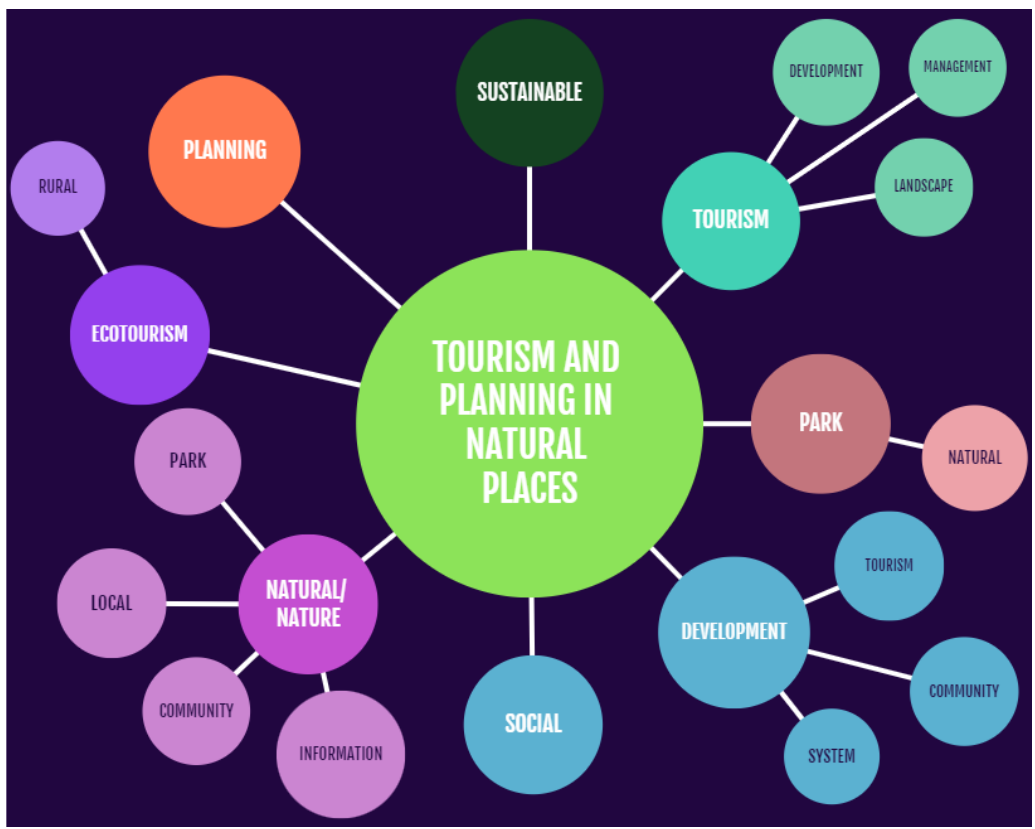
Figure 5. Main thematic correlations in the study area.